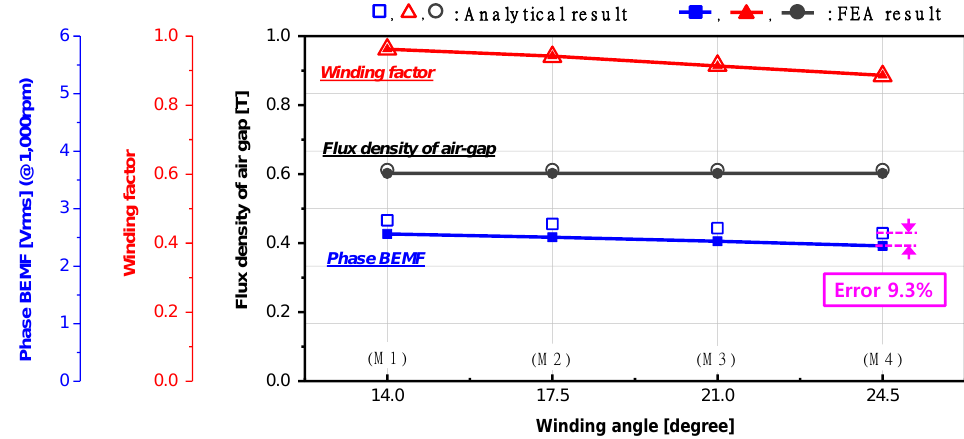
Figure 12. Back EMF trend according to the variation in the winding angle.